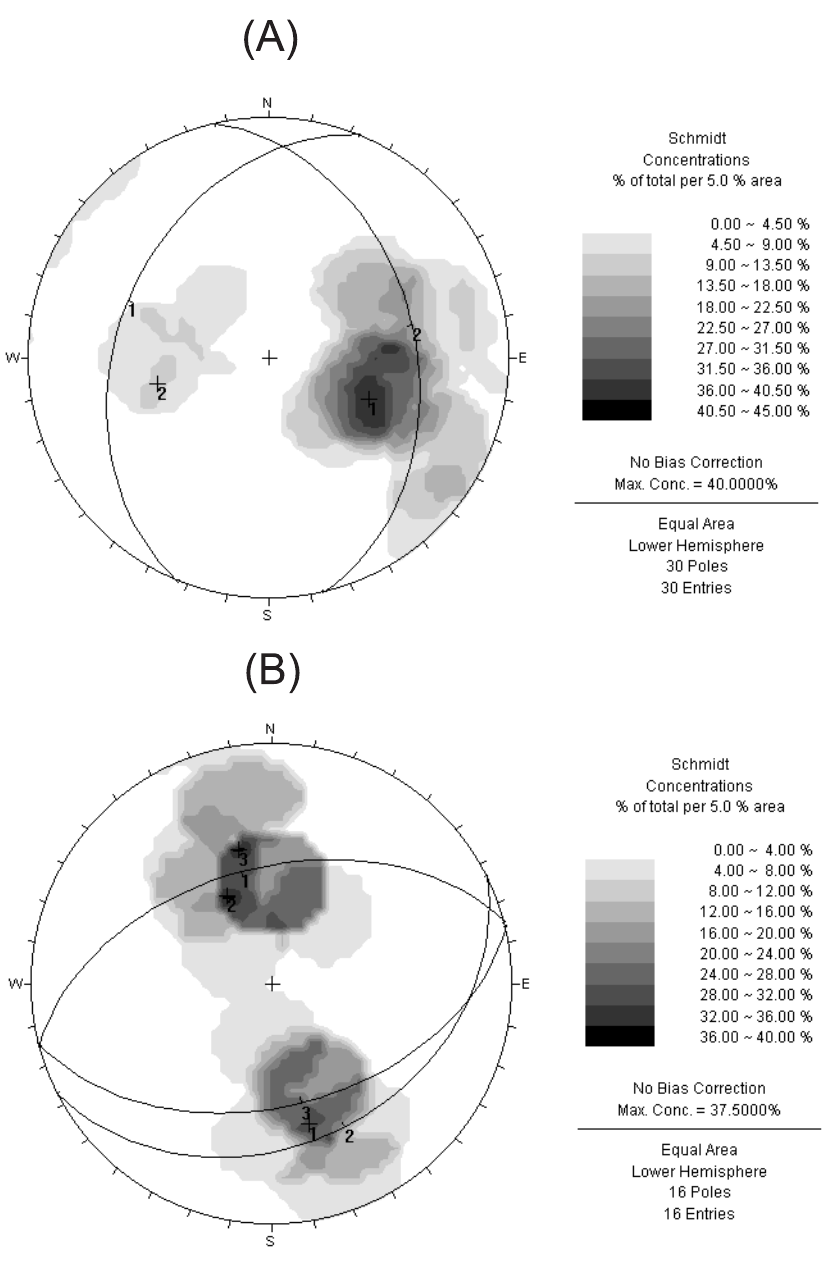
Fig. 3 – Stereograms showing poles of the gneissic banding (a), shearing planes (b), with respective maximum concentration